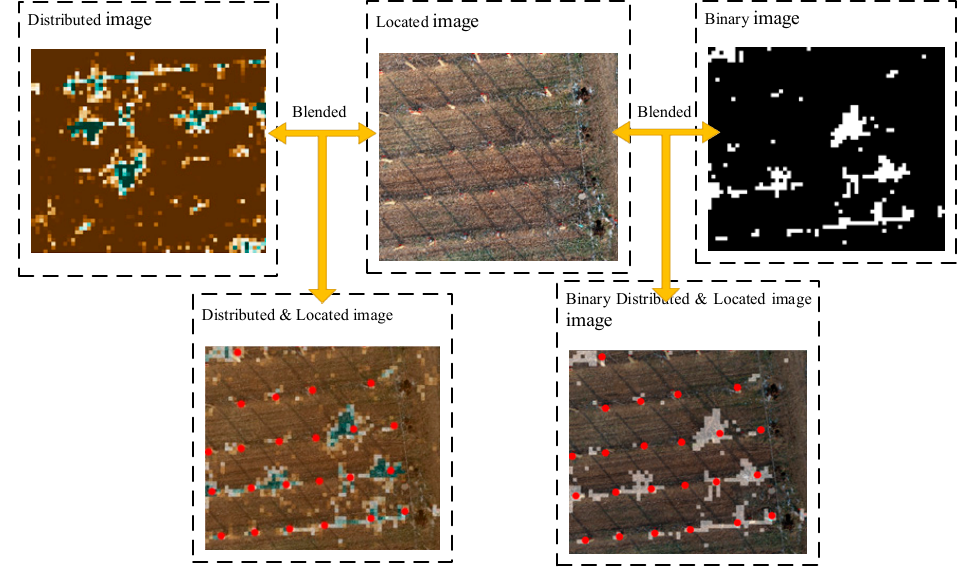
Figure 5. By fusing the resampling distribution image, the binarization distribution image, and the target recognition location image, the binarization location distribution image and the location distribution image are obtained.